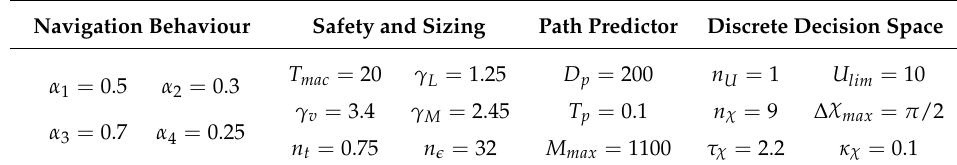
Table 1. RRSOAS parameters in international units, which have been tuned in scenario 3 of Figure 3. Navigation Behaviour Safety and Sizing